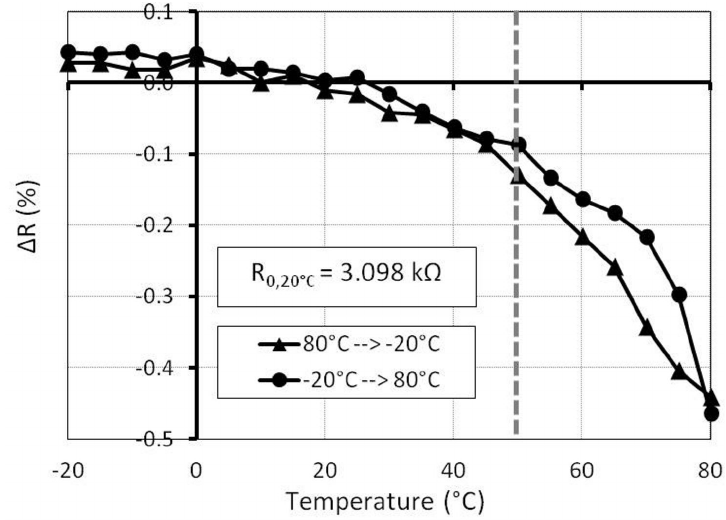
Figure 13. Temperature dependency of the Wheatstone bridge (sample with 2